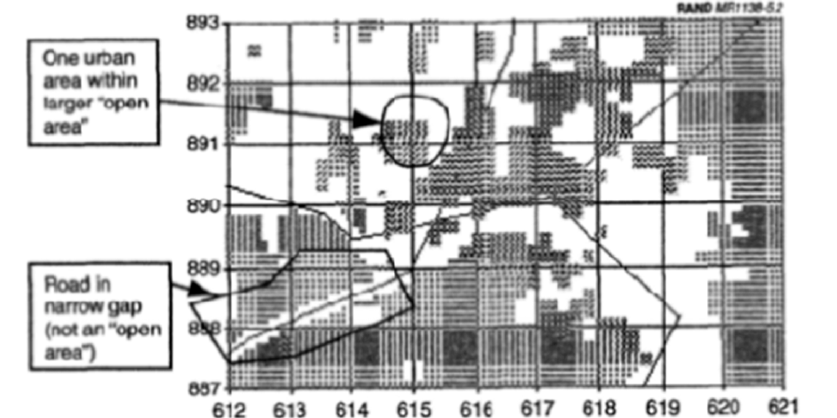
Figure 5. A high-resolution depiction of terrain. Source: Figure 5.2 of [60], p.